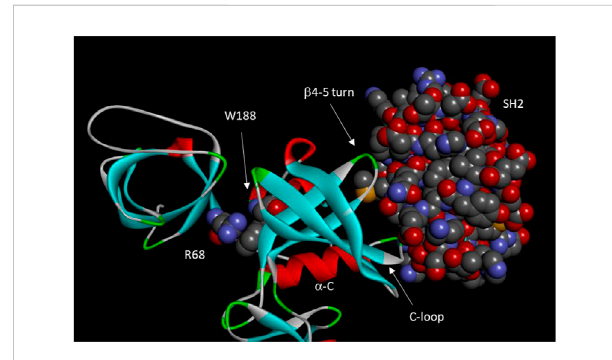
FIGURE 3 Domain-domain interactions in Csk. Important residues and motifs are indicated. Arg68, Trp 188, and the Csk SH2 domain are shown in space- fi lling model. The motifs of a-C, C-loop, and b4-5 turn constitutes an “ on switch ” in Src kinase domain. However, these motifs signi fi cantly diverged from those in Src to become a defective “ on switch ” that can only be turned on by interactions with the SH2